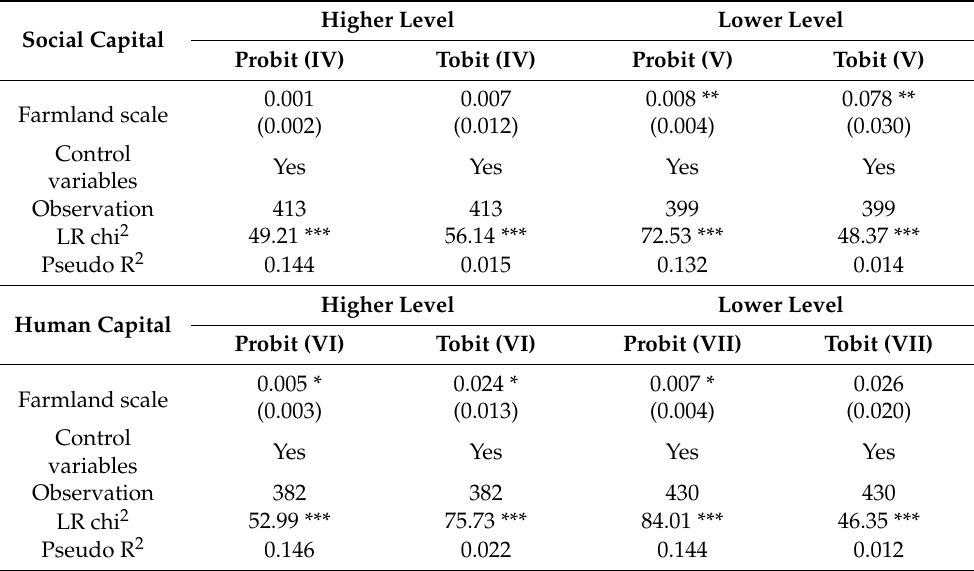
Table 6. Estimation results of group regression model on different